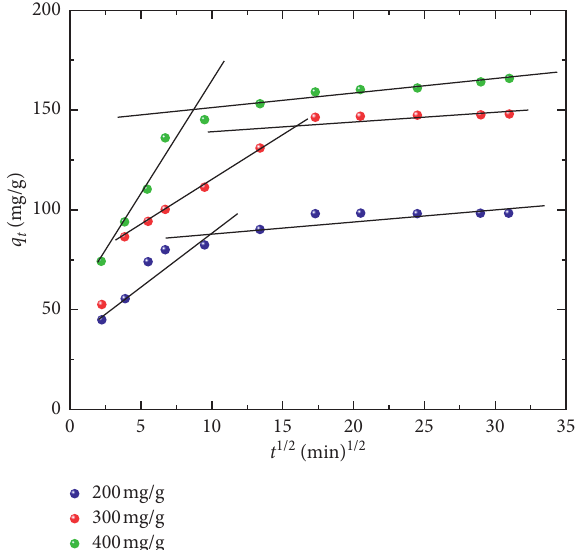
− ions sorption by ZCOBLP. 4